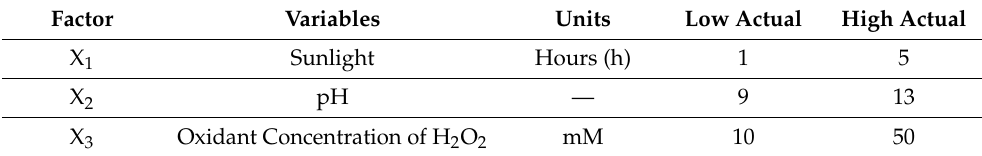
Table 1. Coded reaction parameters and their level ranges investigated for optimization by RSM. Factor